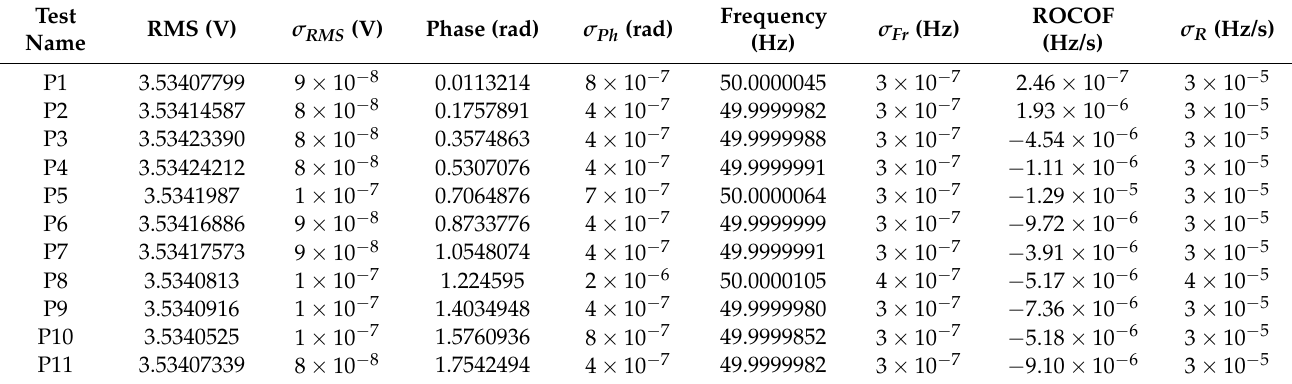
Table 18. Measurement results of the phase tests.